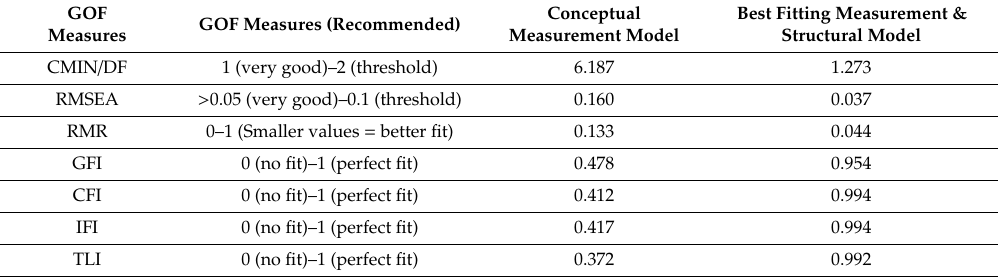
Table 6. Summary of GOF measurement results: (i) conceptual (ii) best fitting measurement and structural